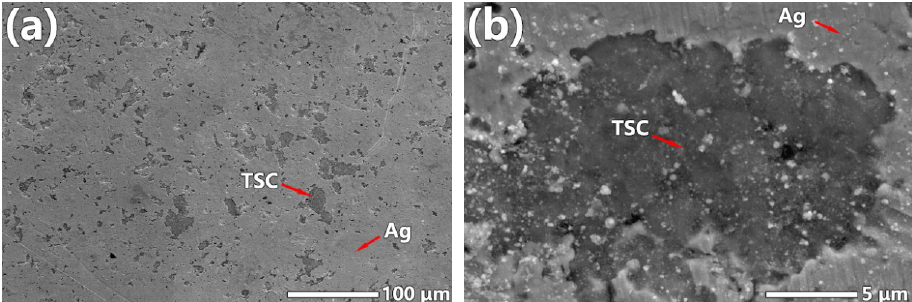
Fig. 6 (a) Representative micro-morphologies of the unaffected region on the contact surface of Ag/10TSC. (b) Enlarged image of Ti 2 SnC particle in Ag matrix.